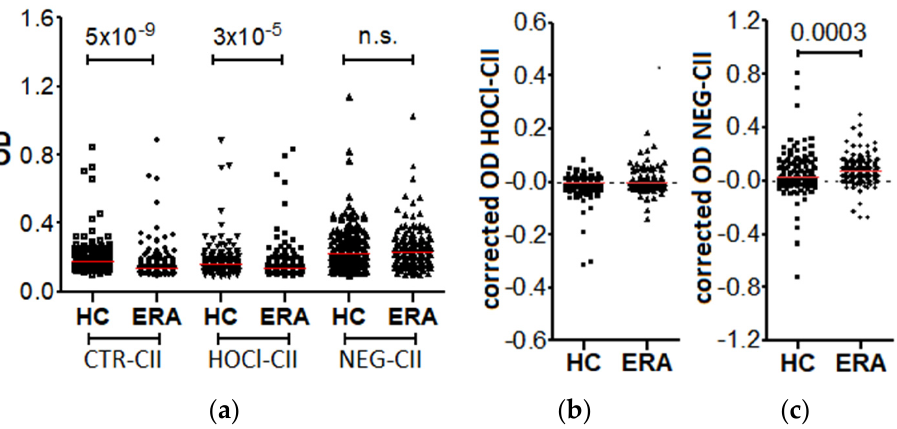
Figure 1. Reactivity against modified CII in patients with early RA (ERA) and healthy controls (HC). ( a ) Reactivity measured as OD before correction; ( b ) anti-HOCl-CII; and ( c ) anti-NEG-CII specific reactivities, obtained after subtracting the OD against the CTR-CII. The red line represents the median OD value in each group. n.s. = non significant.